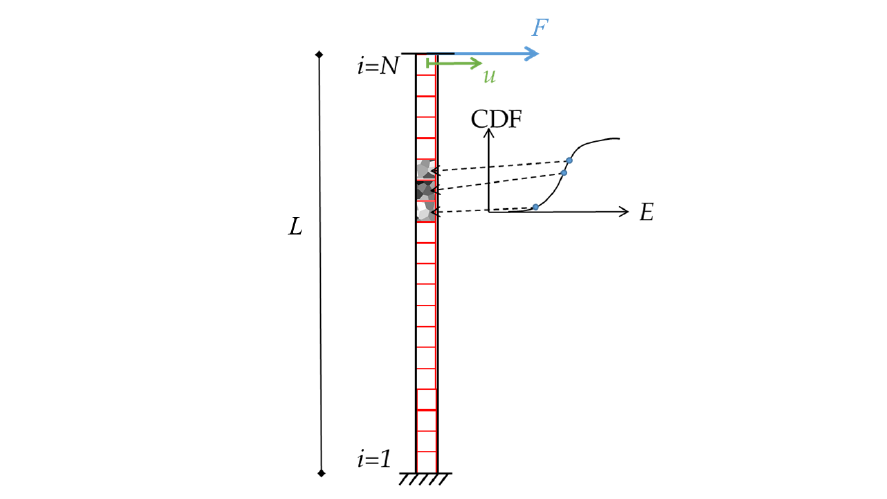
Figure 9. Scheme adopted for the calculation of the scattered spring stiffness with the spring itself subdivided into N subsets, each one with a Young’s modulus sampled from the relevant size-dependent CDF and a moment of inertia dependent on the